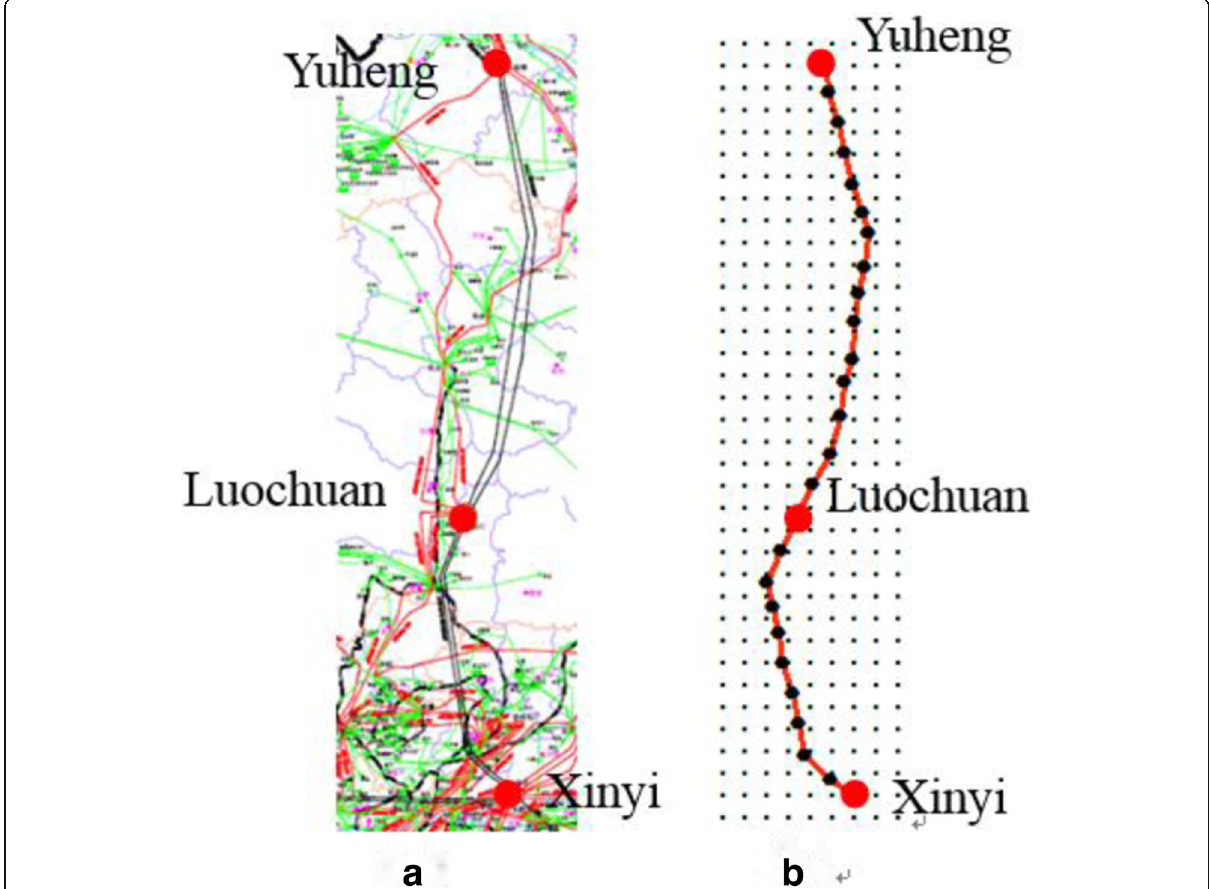
Fig. 4 The geographical location of the studied line: a geographic wiring diagram and b meteorological data